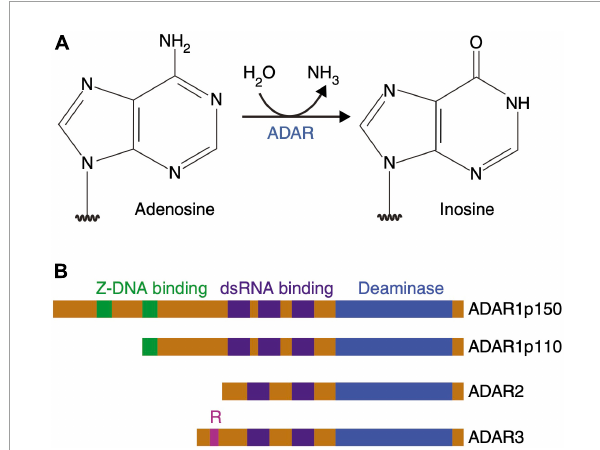
FIGURE7 Adenosine deamination and the ADAR enzyme family. (A) ADAR enzymes catalyze the A-to-I hydrolytic deamination reaction, by which an adenosine loses an amine group and is converted to inosine. (B) There are four main proteins of the ADAR enzyme family: two isoforms of ADAR1 (p110 and p150), ADAR2 and ADAR3. All of these enzymes contain a conserved deaminase domain, shown in blue. The double-stranded (ds) RNA-binding domains, shown in purple, determine substrate specificity. The two ADAR1 isoforms differ in their Z-DNA-binding domains, shown in green. ADAR3 contains an arginine-rich domain, shown in pink, which binds single-stranded RNA. Figure from Slotkin and Nishikura (2013), obtained by Springer Nature under license No